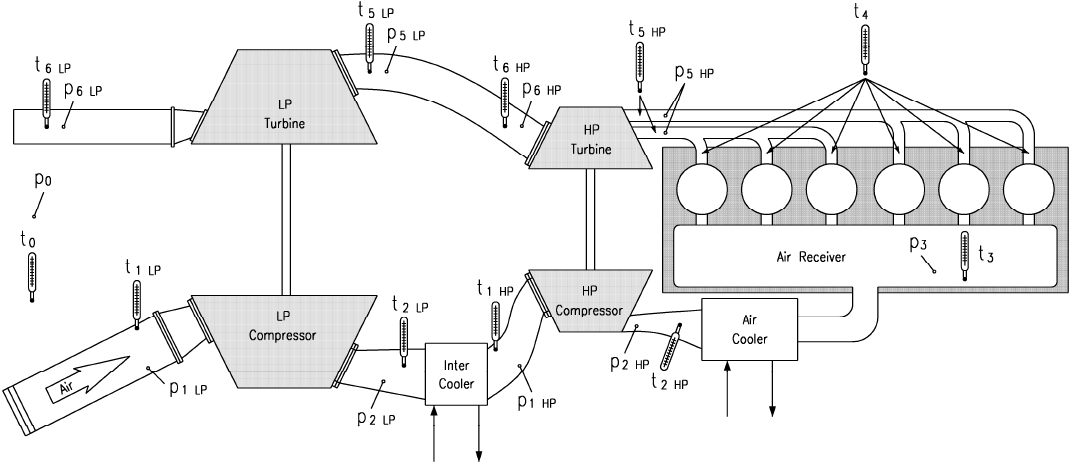
Figure A2. WIT convention: Double-stage case.